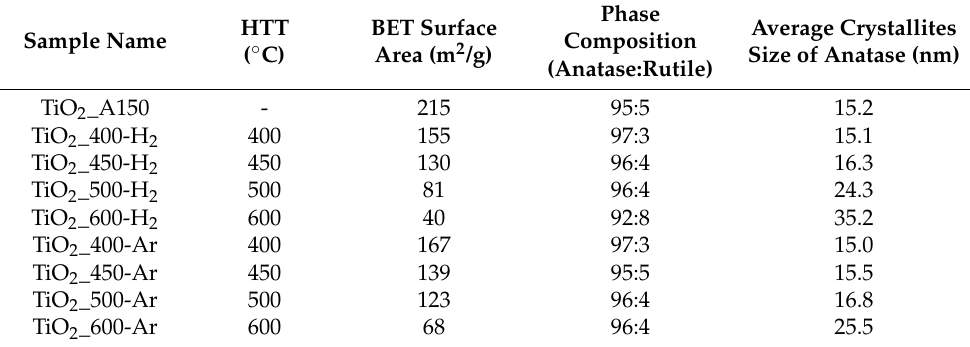
Table 1. Brief characteristics of the titania samples heat-treated under H 2 and